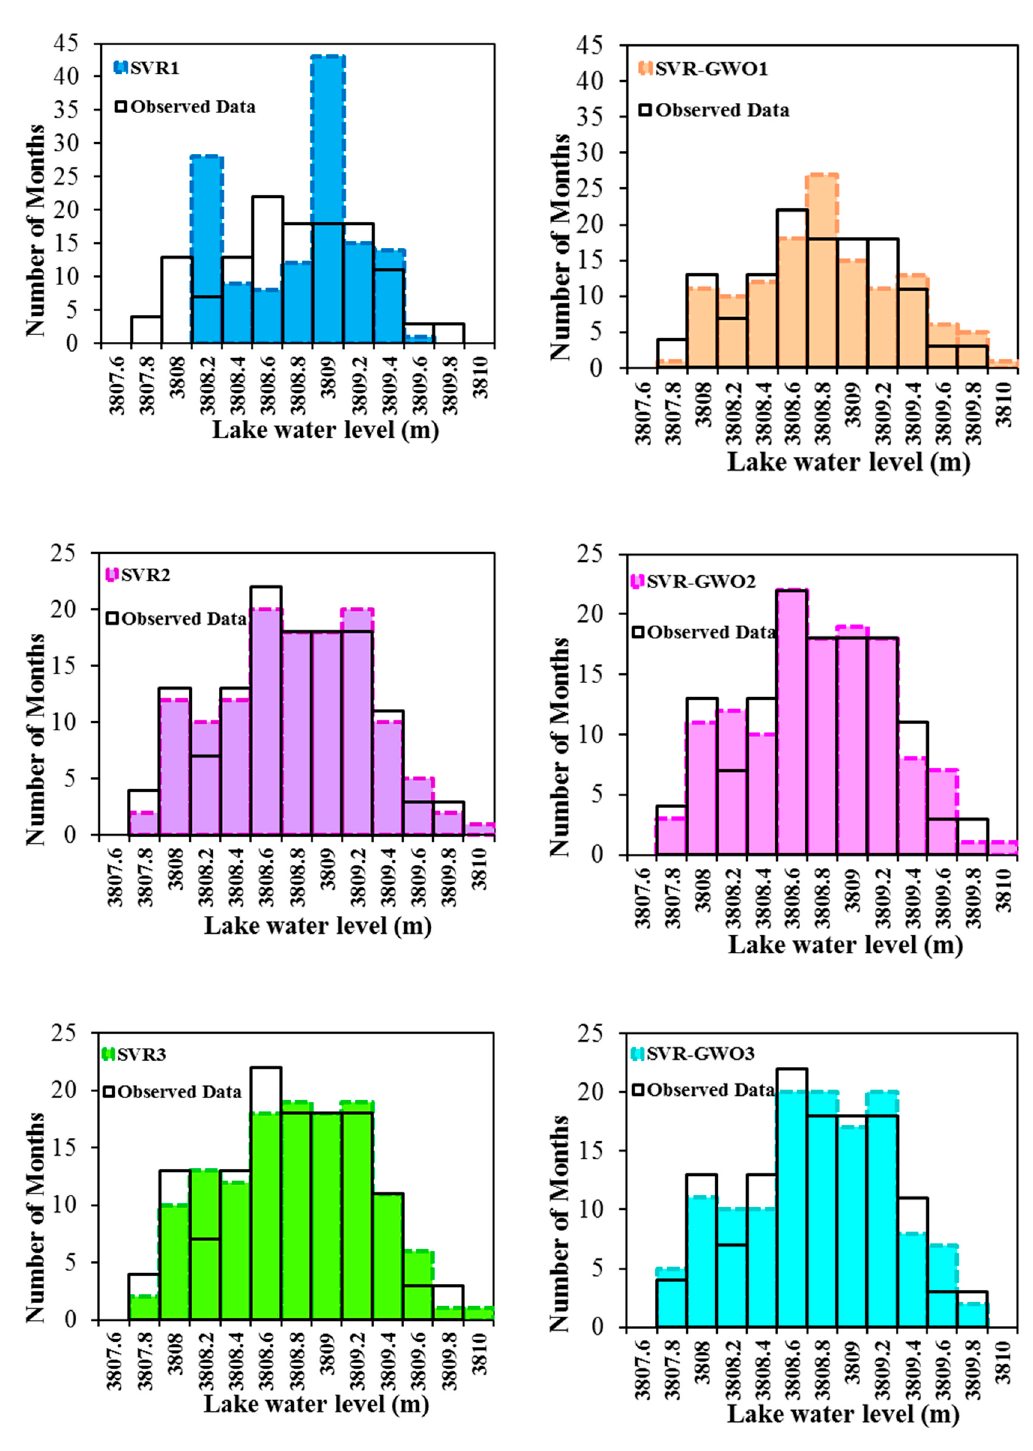
Figure 12. The histogram of the predicted and the observed ratio of lake level in the testing period, the data comparison intervals were selected from 3807.6 m to 3810 m.